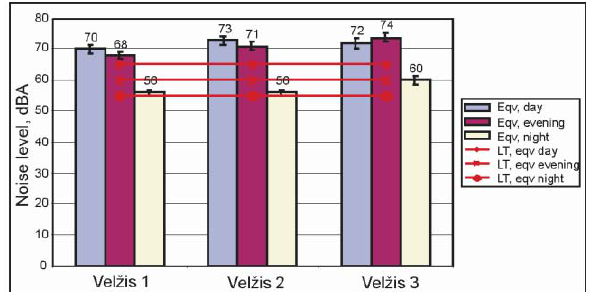
Fig. 2. Dynamics of equivalent noise levels in Velţis